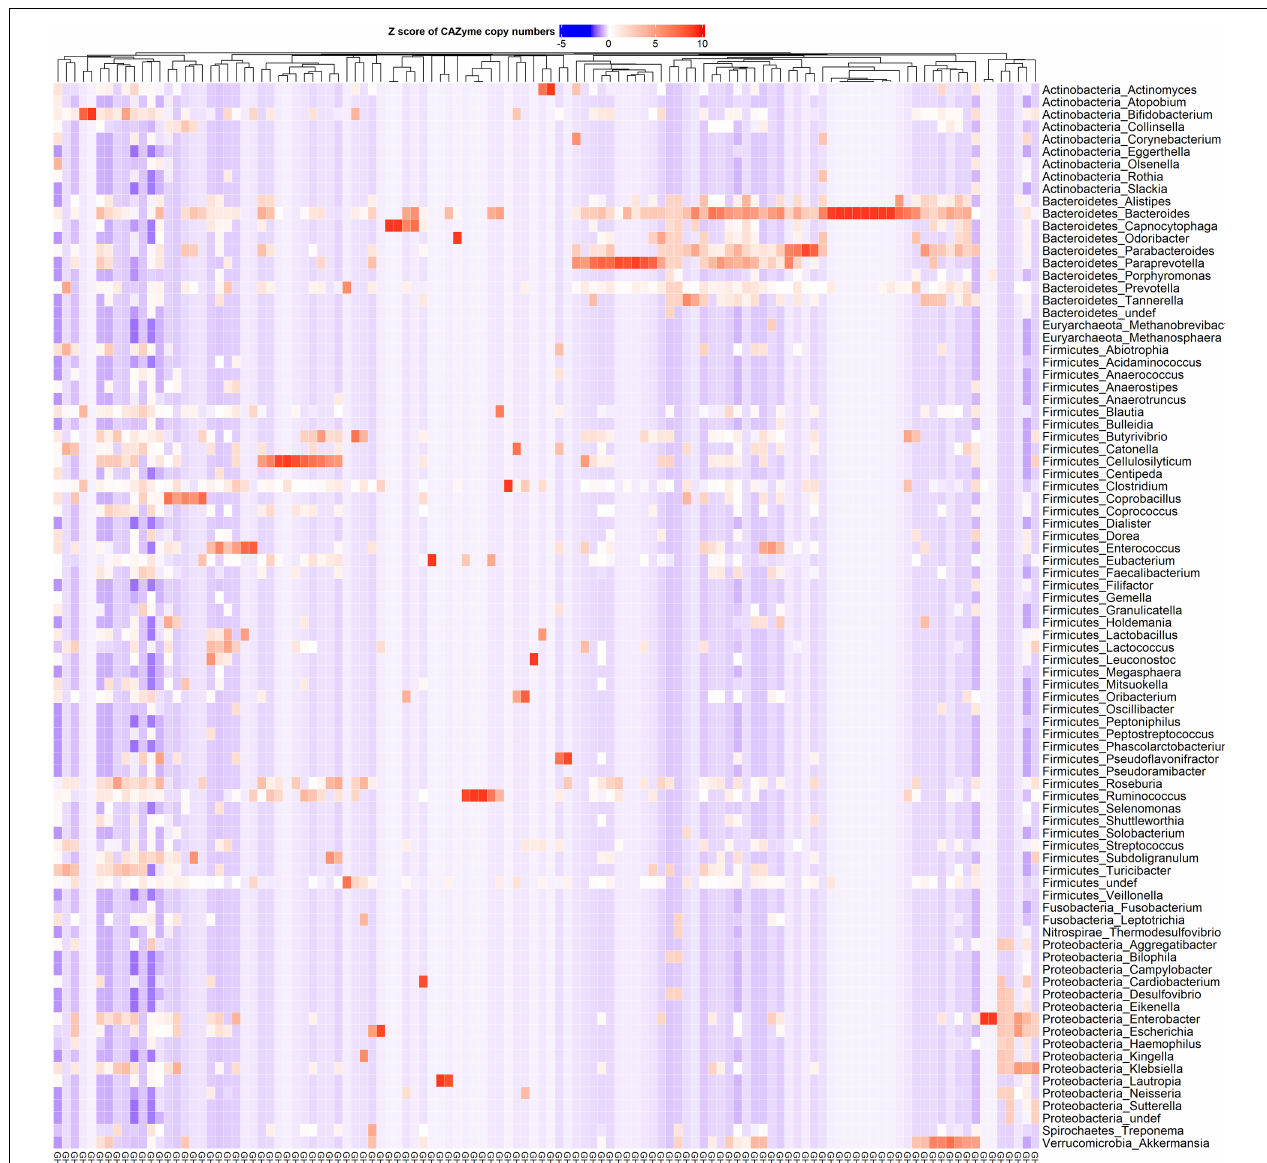
FIGURE 2 | Phylum and genus-specific CAZyme family signatures based on Z score standardization. A heatmap of CAZyme family total gene copy number annotated from 310 reference genomes in 935 metagenomes obtained from the oral (saliva) and gut (fecal) samples of healthy subjects, as well as patients suffering from type 1 diabetes, colorectal cancer, and rheumatoid arthritis. In total, 116 distinct glycosylhydrolases (GHs) families from nine phyla and 86 genera are represented. Each genus displays specific CAZyme enrichments covering a broad carbohydrate range, resulting in a diverse symbiotic microbial